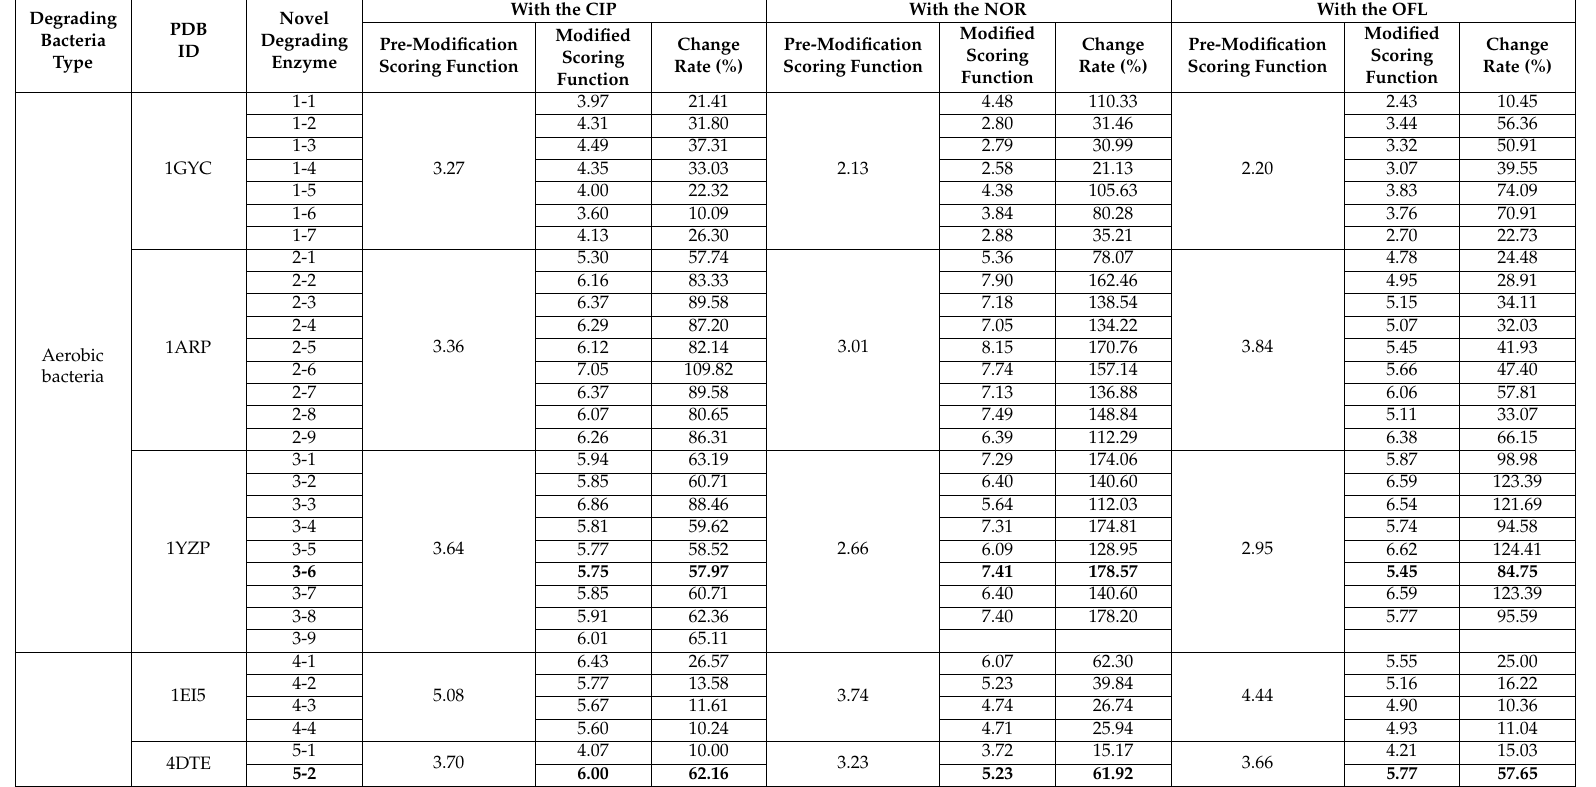
Table 3. Docking scoring function of novel degrading enzymes and target fluoroquinolone